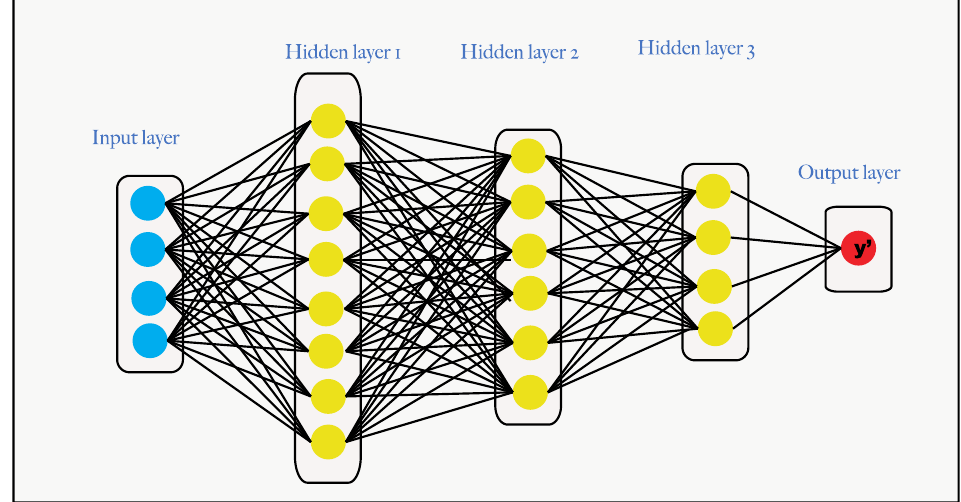
Figure 6. An ANN learns by processing images, where each of which contains an input, hidden, and result layer.